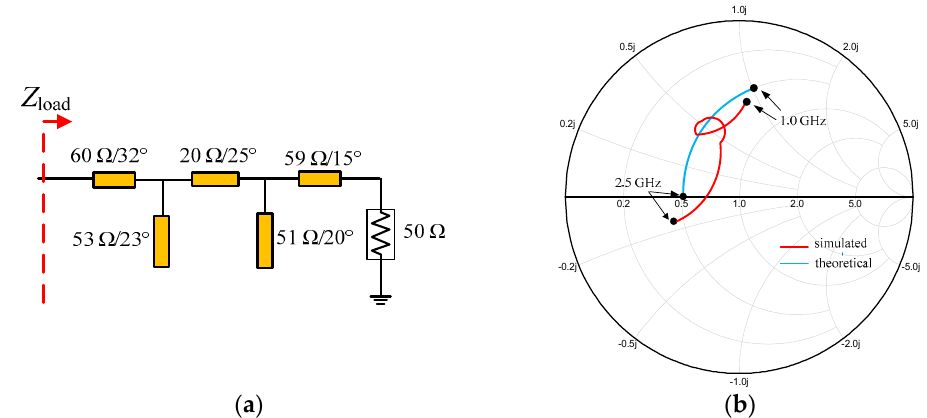
Figure 12. ( a ) Post-matching network; ( b ) simulated impedance Z load (normalized R OPT ).